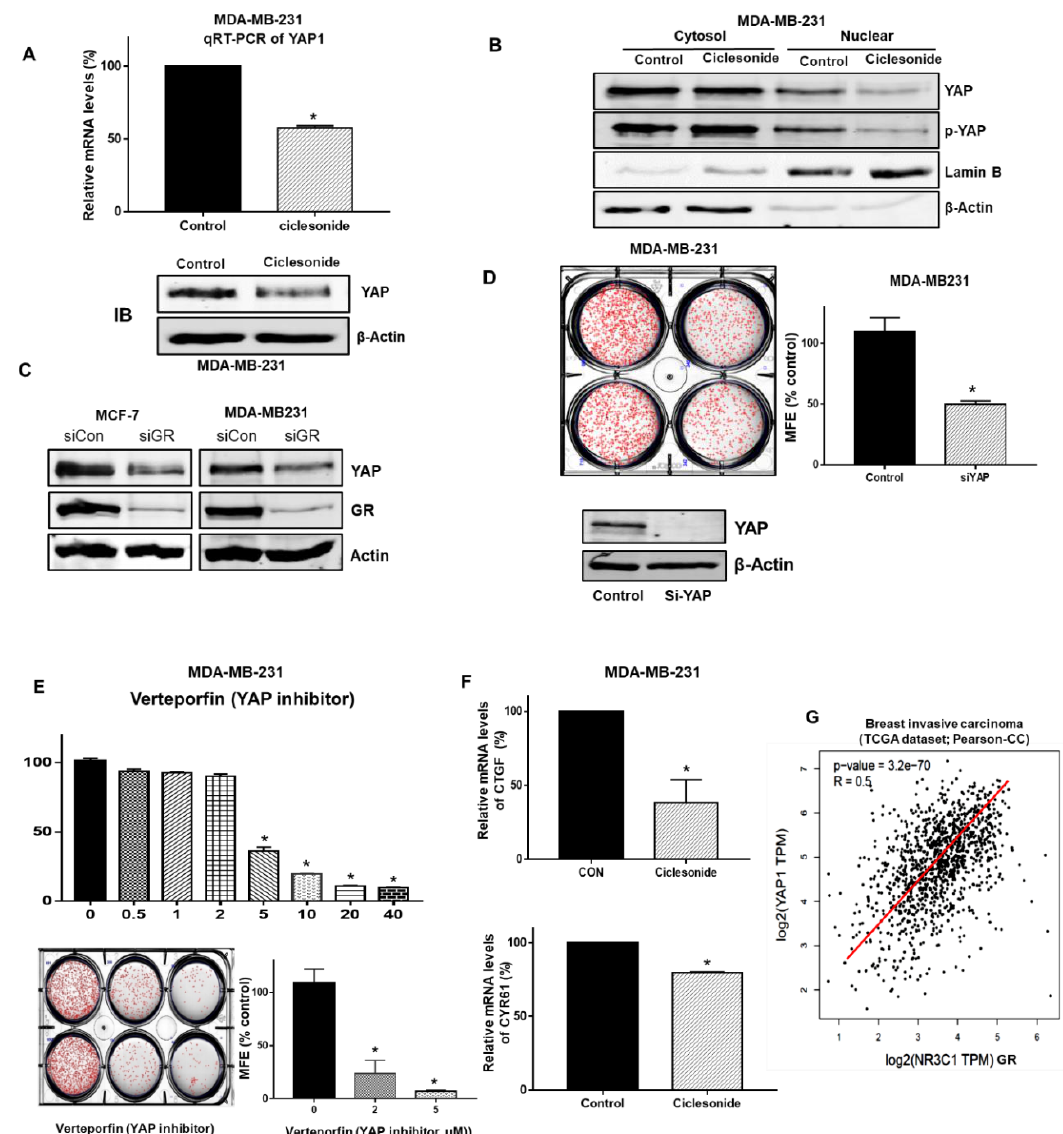
Figure 5. Ciclesonide reduced Yes-associated protein (YAP) nuclear localization and regulated breast CSC formation through YAP signaling. ( A ) After treatment with ciclesonide (10 µ M), the transcript and protein levels of YAP1 were measured by real-time RT-qPCR using specific primers and an anti-YAP1 antibody, respectively. We used β -actin as the internal control. ( B ) Mammospheres were treated with ciclesonide (10 µ M) for 1 day. After separation on 10% PAGE gels, cytosolic and nuclear protein extracts were transferred to membranes, followed by western blotting with anti-YAP and anti-p-YAP1 antibodies. β -actin and Lamin B were used as loading controls for the cytosolic and nuclear protein extracts, respectively. ( C ) siRNA-mediated silencing of GR decreased the expression of YAP and GR proteins in MCF-7 and MDA-MB-231 cells. GR protein expression was downregulated via GR siRNA, and the protein levels of YAP1 and GR were measured with anti-GR and anti-YAP1 antibodies. ( D ) siRNA-mediated silencing of YAP1 induced a significant decrease in the MFE in MDA-MB-231 cells. YAP1 was downregulated in MDA-MB-231 cells by YAP1 siRNA, and a mammosphere formation assay was performed with these cells. The experiment was conducted with cancer cells treated with ciclesonide in a single passage of spheres formation assay. ( E ) Treatment with verteporfin, a suppressor of YAP-TEAD complex formation, resulted in a decrease in the MFE in MDA-MB-231 cells. The cancer cells were cultured in a 96-well plate with the indicated concentration of verteporfin. The proliferation of the cells was measured with MTS reagent. Data from